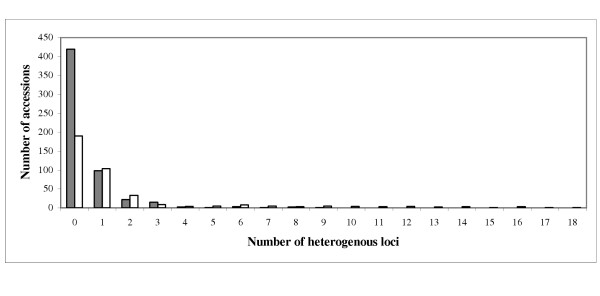
Structure of heterogeneity detected in 953 barley accessions. The columns represent heterogeneity in 565 European accessions (in grey) and in 388 accessions from other geographic regions (in white).